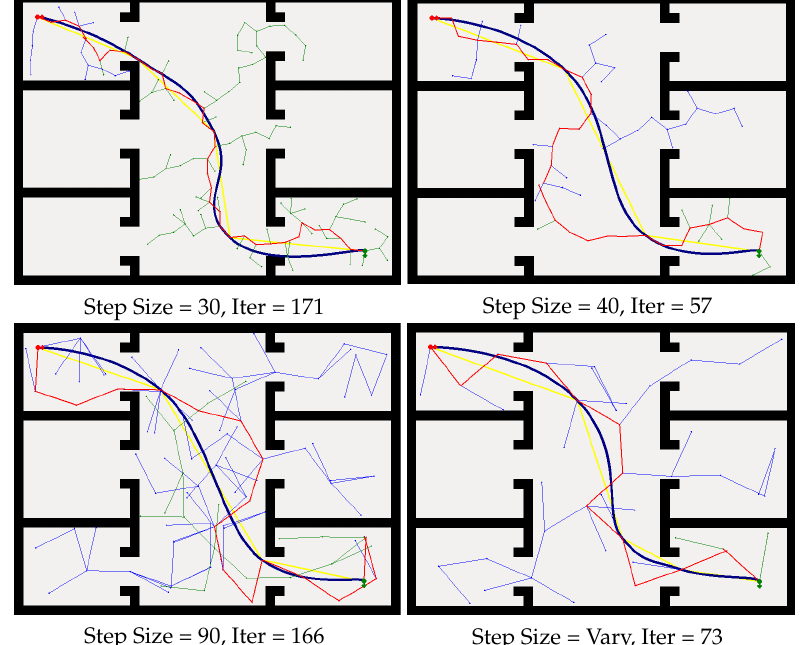
Figure 6. Path planning with limited step size RRT and our method. Blue line: RRT method. Red line: initial path form the start to the goal. Yellow and blue lines: optimization of the initial